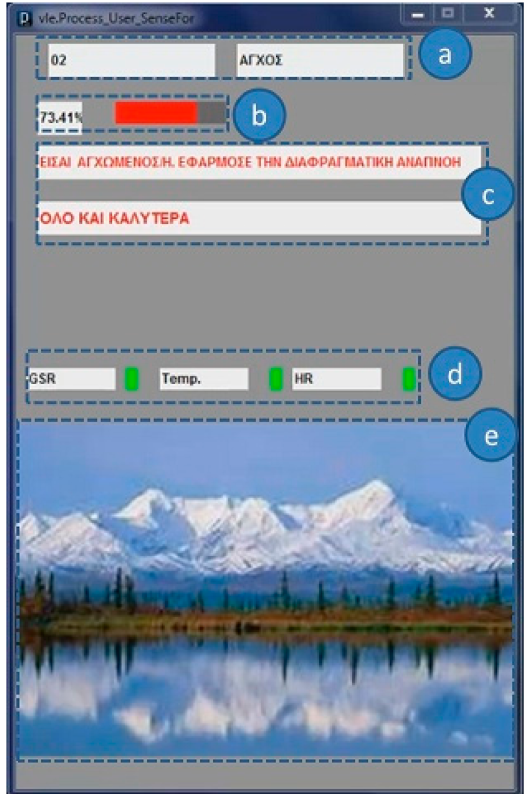
Figure 3. Biofeedback application user interface. ( a ) Biofeedback application interface, ( b ) Anxiety level percentage, ( c ) Encouragement for diaphragmatic breath, ( d ) Indication of well-functioning sensors, ( e ) Display pictures for relaxation.